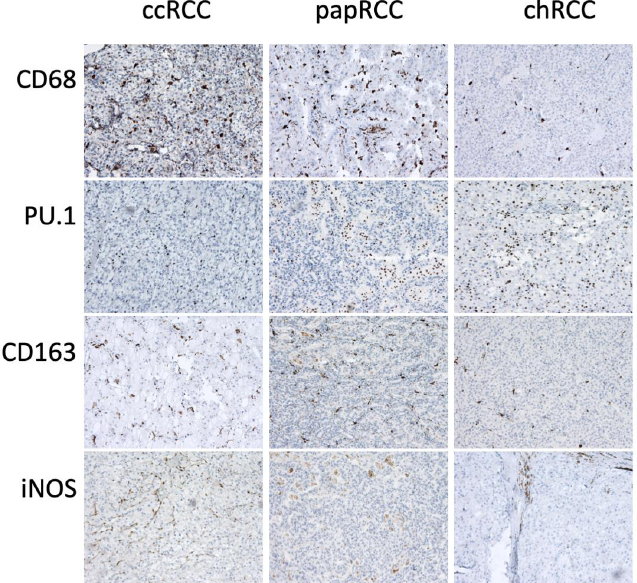
Biomedicines 2022 , 10 , x FOR PEER REVIEW Figure 5. Immunohistochemical staining of RCC samples for macrophage markers CD68, PU.1, CD163 and iNOS. Magnification is 400×.